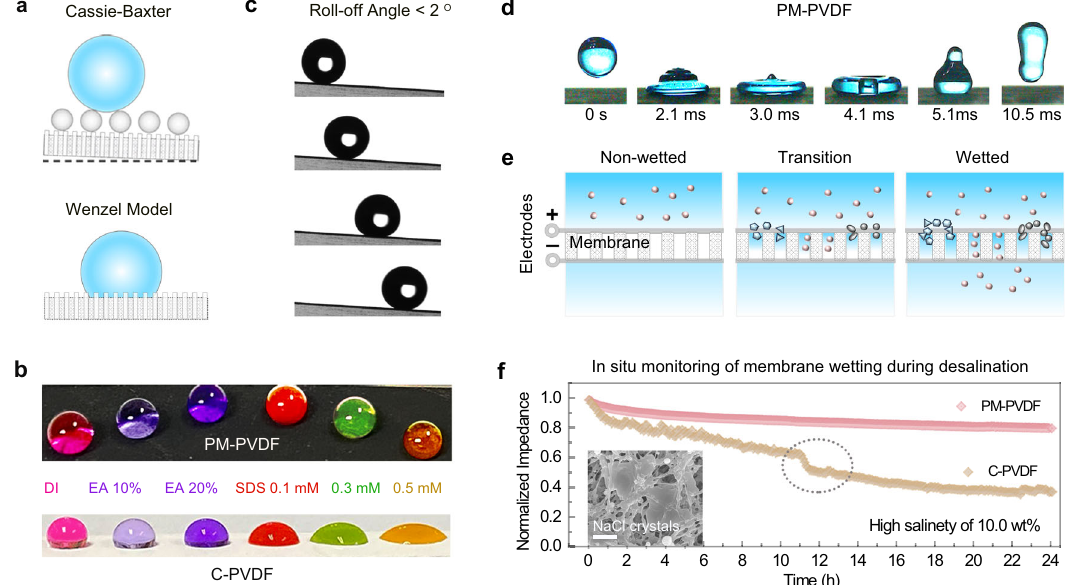
Fig. 4 Water repellency and membrane wetting resistance. a A schematic illustration of a water droplet in the Cassie-Baxter state on the PM-PVDF and the Wenzel model state on the C-PVDF, respectively. b Photography of different solvent droplets on the C-PVDF and the PM-PVDF, respectively. From left to right: DI water, 10 and 20% ethanol (EA) in water, 0.1 mM, 0.3 mM and 0.5 mM sodium dodecyl sulfate (SDS) in water. c Low slide angle of the PM- PVDF. d Selected snapshots of a water droplet impinging on the superhydrophobic membrane surface. e Schematic illustration on wetting-induced membrane issues monitored by the evolution of membrane impedance during desalination. The wetting transition would induce a cross-membrane permeation of the salt ions from feedwater and a further accumulation of crystals inside of the membrane pores, which could be directly re fl ected by the decline of membrane ’ s impedance. f Normalized membrane impedances in situ monitored during hypersaline solution treatment. Scale bar: 5 μ m. The dotted circle represents the transition stage of impedance accompanied by aggravating membrane wetting. Inset is SEM image of C-PVDF with the crystals scaling inside of the membrane pores. Source data are provided as a Source Data fi